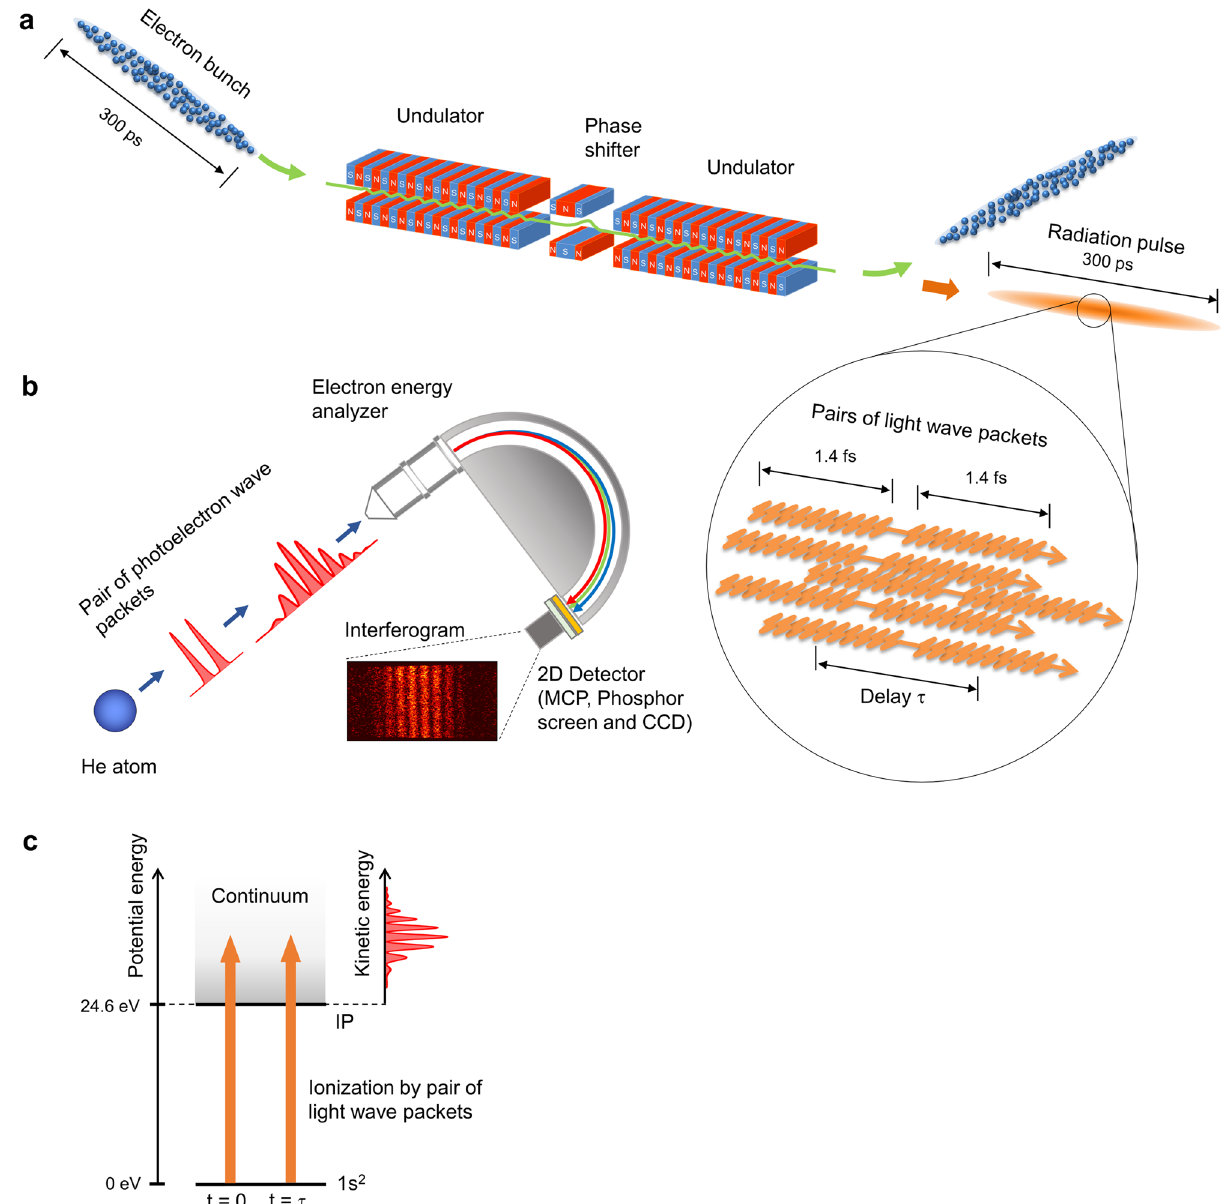
Figure 1. Experimental layout for time-domain double-slit interference by synchrotron radiation. ( a ) Spontaneous radiation is emitted from a bunch of relativistic electrons passing through the tandem-undulator in the UVSOR-III synchrotron ring. Each of the relativistic electrons in the bunch emits a pair of light wave packets, reflecting the sequential undulating motion in two undulators. Numerous pairs of light wave packets are randomly distributed in the radiation pulse. ( b ) A pair of photoelectron wave packets is emitted from a helium atom that interacts with the pair of light wave packets. The interfering photoelectron wave packets are observed as an interferogram on the detection plane of the hemispherical electron energy analyzer. The buildup of quantum interference pattern is monitored by a 2D detector which allows for one-by-one detection of the photoelectrons, which stochastically arrive at the detector plane. ( c ) Energy level diagram of helium atom and the ionization process by a pair of light wave photoelectrons measured with pairs of light wave packets. The CCD image after accumulation of 2000 electrons shows an almost random distribution. An interference pattern exhibiting the wave-like nature of single photo- electrons appears at 2 × 10 4 electrons, and becomes clearer as the number of electrons is increased. One-dimensional photoelectron spectra are obtained from the two-dimensional images at N e ~ 1 × 10 6 by integrating the photoelectron counts onto the horizontal axis (Fig. 2d–f). The photoelectron spectra obtained by the single-undulator show single peak structures centered at around 4.5 eV kinetic energy. In contrast, the photoelectron spectrum measured with the tandem-undulator is characterized by an interference pattern. The